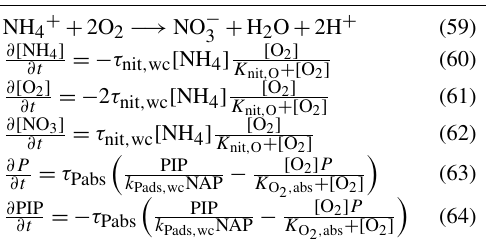
Table 9. Equations for the water column inorganic